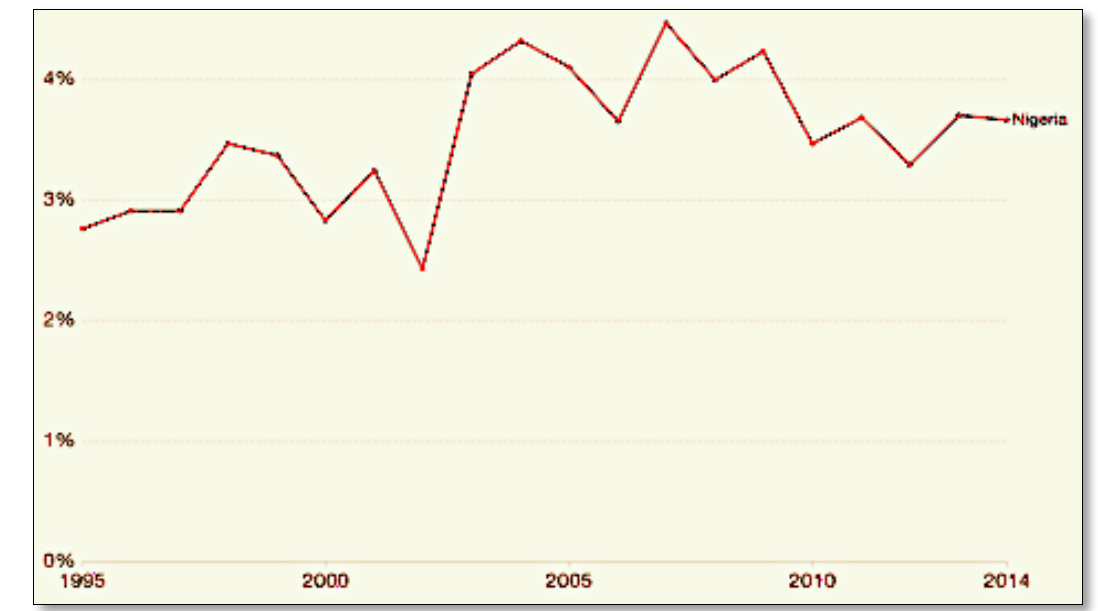
Figure 3. Nigeria’s Government Healthcare Expenditure between 1995 and 2014 as a component of social spending. Source: Author.